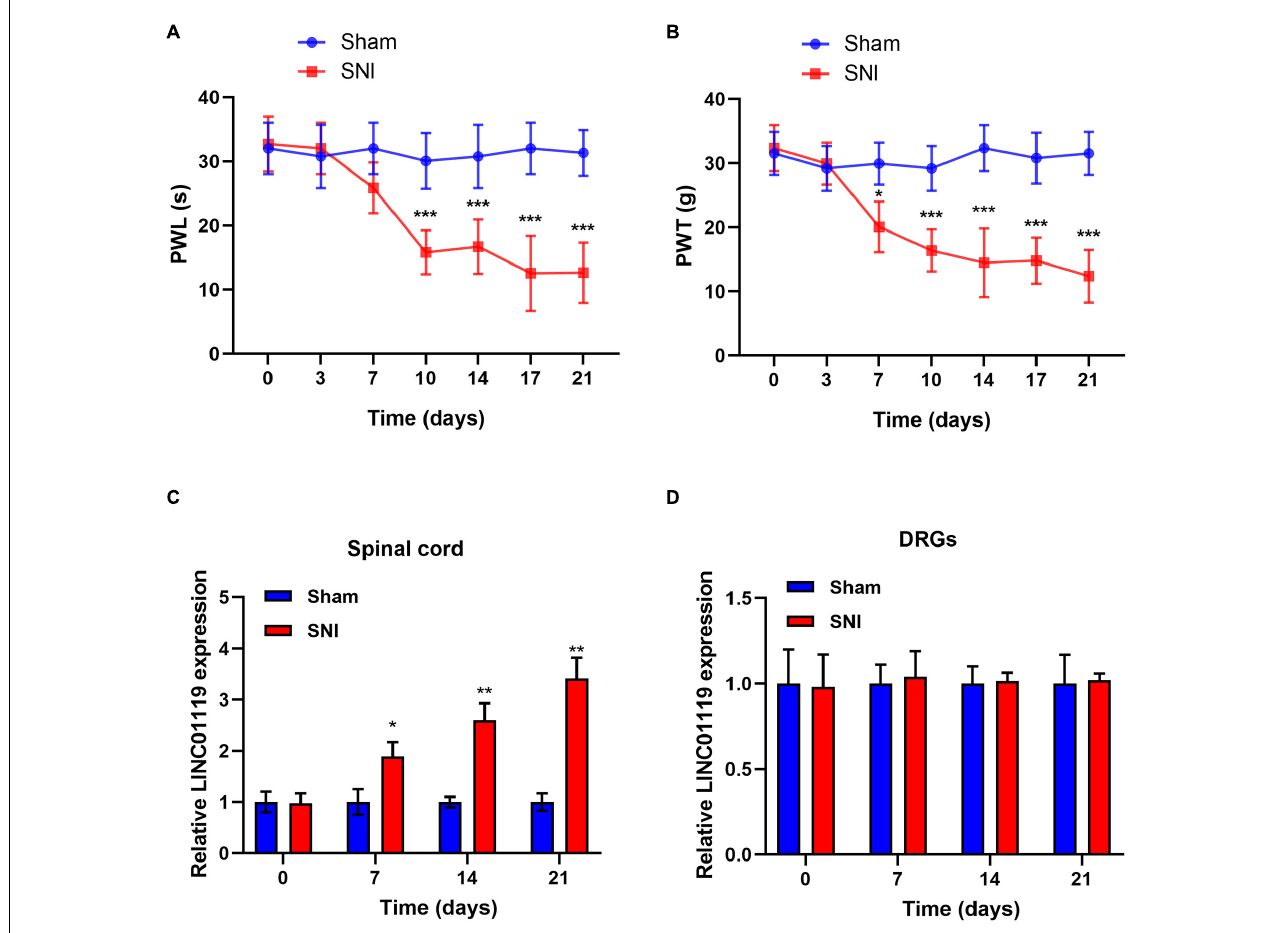
FIGURE 1 | LINC01119 was upregulated in rats with SNI (A,B) PWL (A) and PWT (B) in rats of Sham group and SNI group, * P < 0.05, *** P < 0.001 compared to Sham group, n = 5/group. (C,D) The expression level of LINC01119 were detected in rats of SNI and control group from spinal cord (C) and DRGs (D) at day 0, 7, 14, and 21. * P < 0.05, ** P < 0.01 compared to Sham group, n =